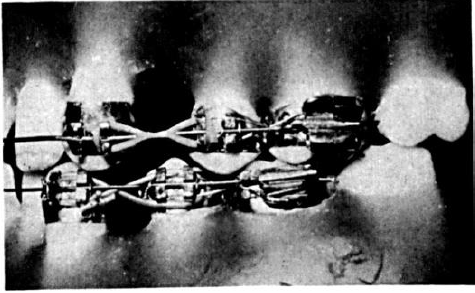
Figure (1): Using of elastic thread for canine retraction in the lower